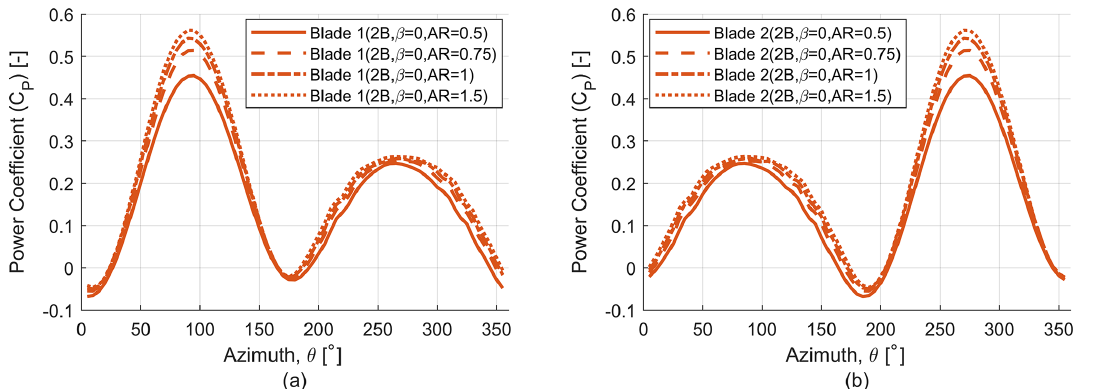
Figure 19. Individual blade power coefficient ( C P ) for different aspect ratio (AR)